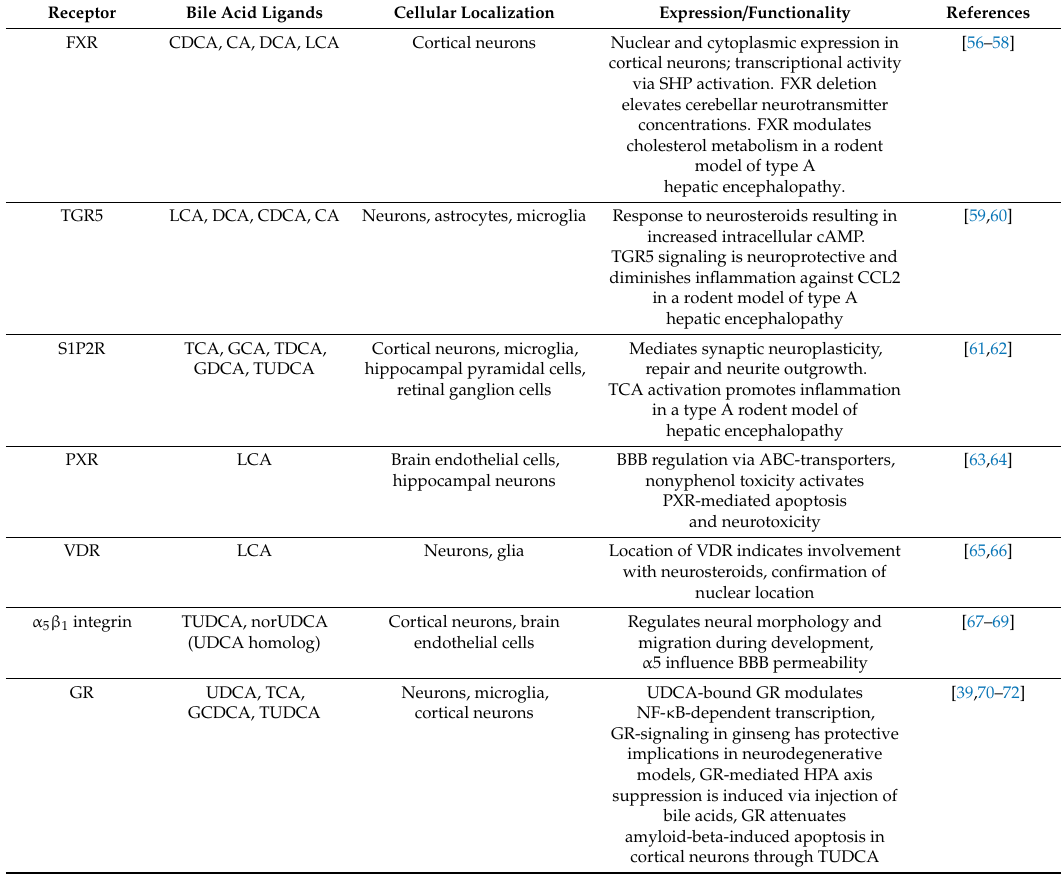
Table 1. Bile Acid Receptors in the